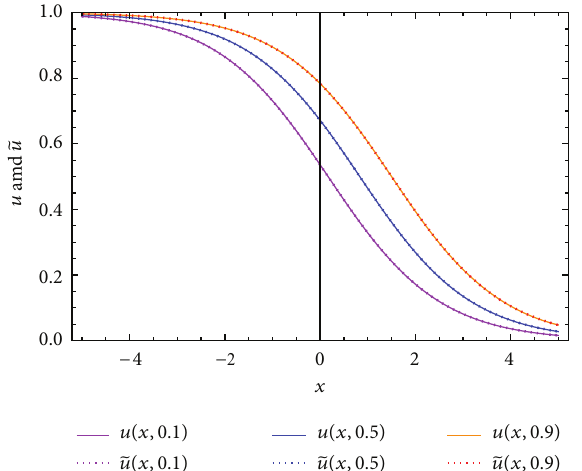
Figure 6: The approximate and the exact solutions for different valuesof 𝑡 (0,0.5,and0.9)ofproblem(44)with 𝜃 = 𝜗 = 0 , 𝜆 1 = 0.01 , 𝜏 = 0.5 , and 𝑁 = 40 .